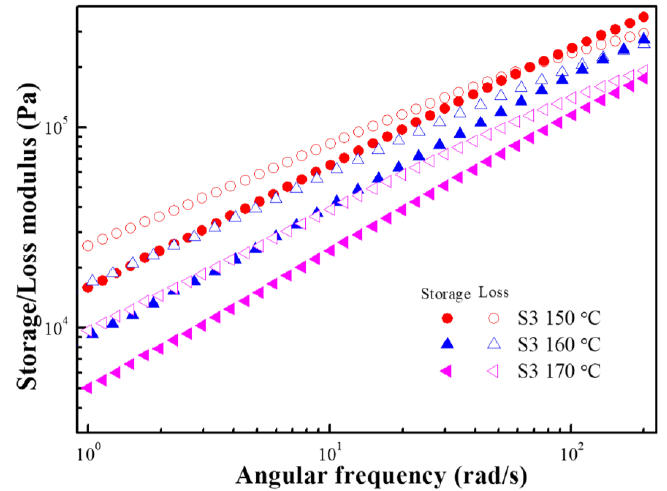
Figure 15. Frequency-dependent storage modulus (closed symbols) and loss modulus (open symbols) of S3 at various temperatures.